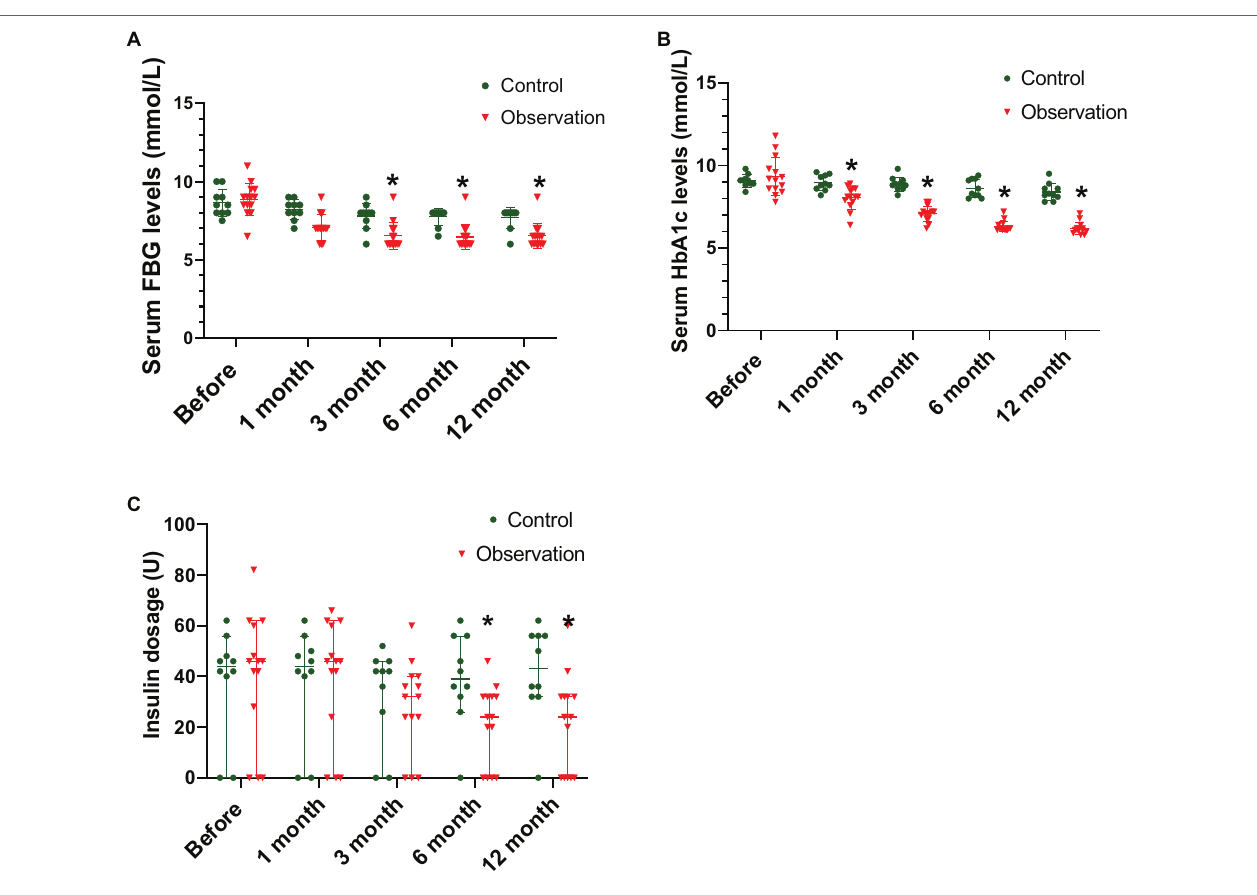
FIGURE 2 | Comparison of disease control in DLC patients with T2DM before and after ABMI. (A) The serum FBG levels in the two groups before and after ABMI. (B) The serum HbA1c levels in the two groups before and after ABMI. (C) The insulin dosage in the two groups before and after ABMI. DLC, decompensated liver cirrhosis; T2DM, type 2 diabetes mellitus; ABMI, autologous bone marrow infusion; FBG, fasting blood glucose; and HbA1c, glycosylated hemoglobin; Compared with control group, * p <